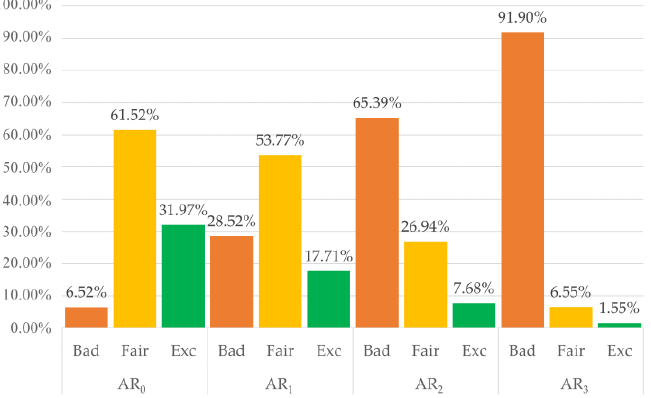
Figure 6. Distribution of the three quality classes among different activity ranges (AR). B = Bad, F = Fair, E = Excellent.